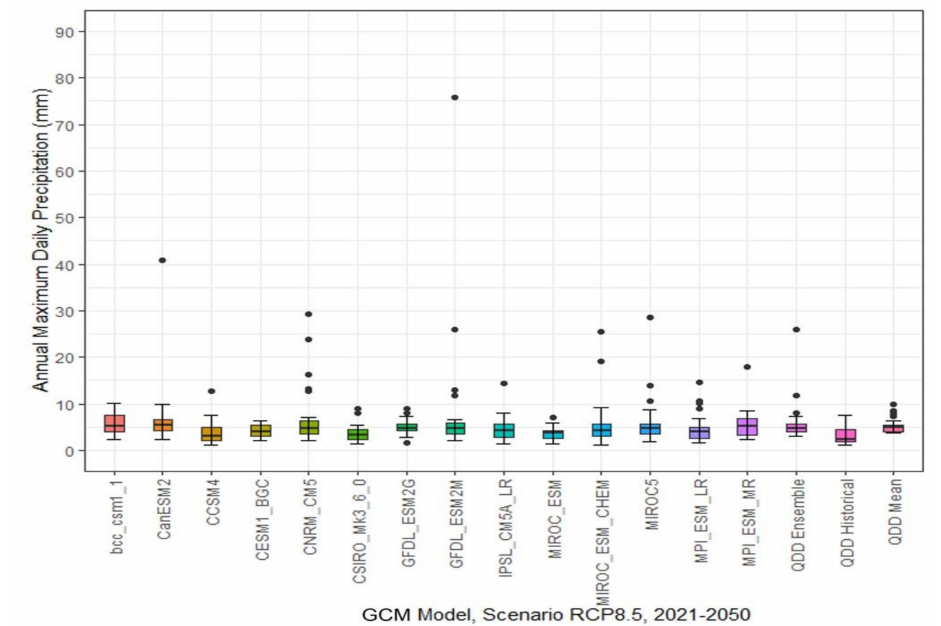
Figure 15. Boxplot for future projections of the annual maximum daily precipitation of 14 GCMs under the RCP8.5 scenario in the Devil’s Creek, period 2021–2050. The linear extensions represent the highest and lowest values; the upper, middle and lower limits of the box represent the percentiles of 75%, 50%, and 25%, respectively; and the solid circles represent the outliers.